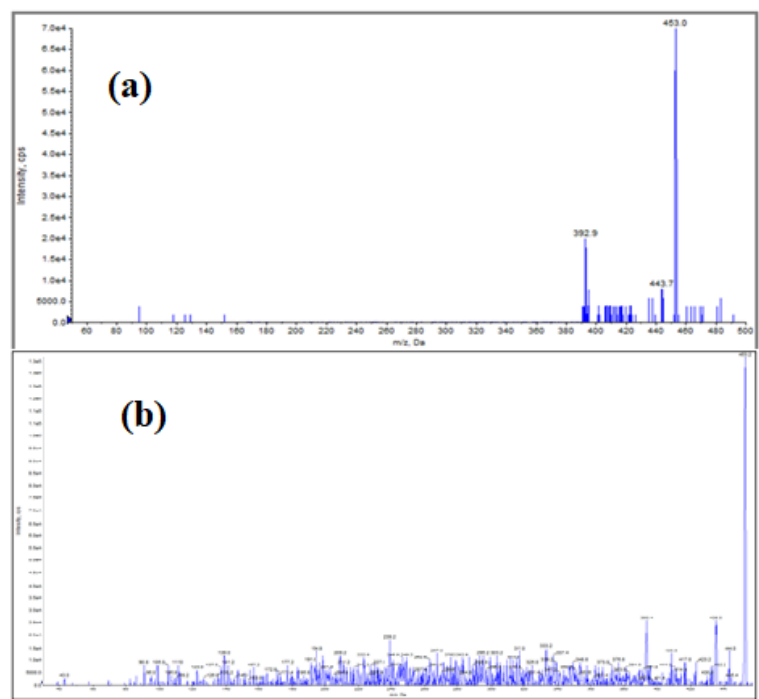
Fig. 13. LC-MS of (a) Before degradation of Orange G dye, (b) After degradation of Orange G dye.